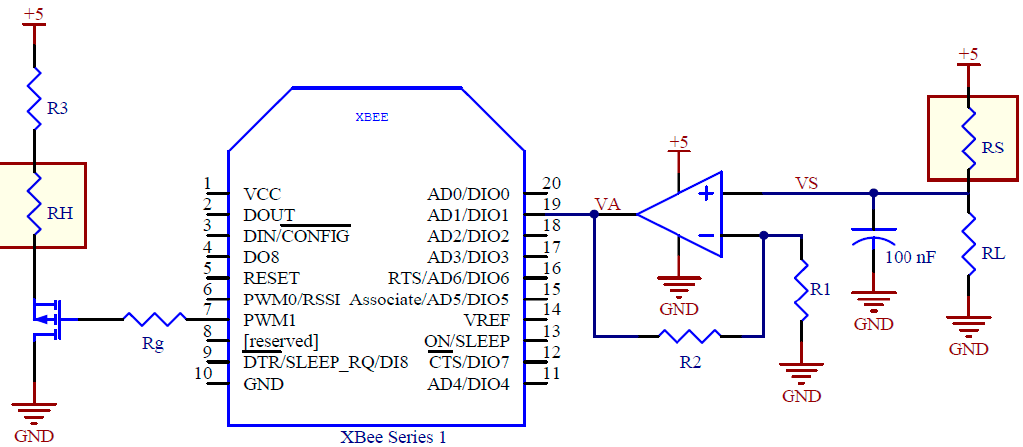
Figure 6. Electrical diagram of the sensor signal conditioning circuits and of the control of the heating power in PV4.